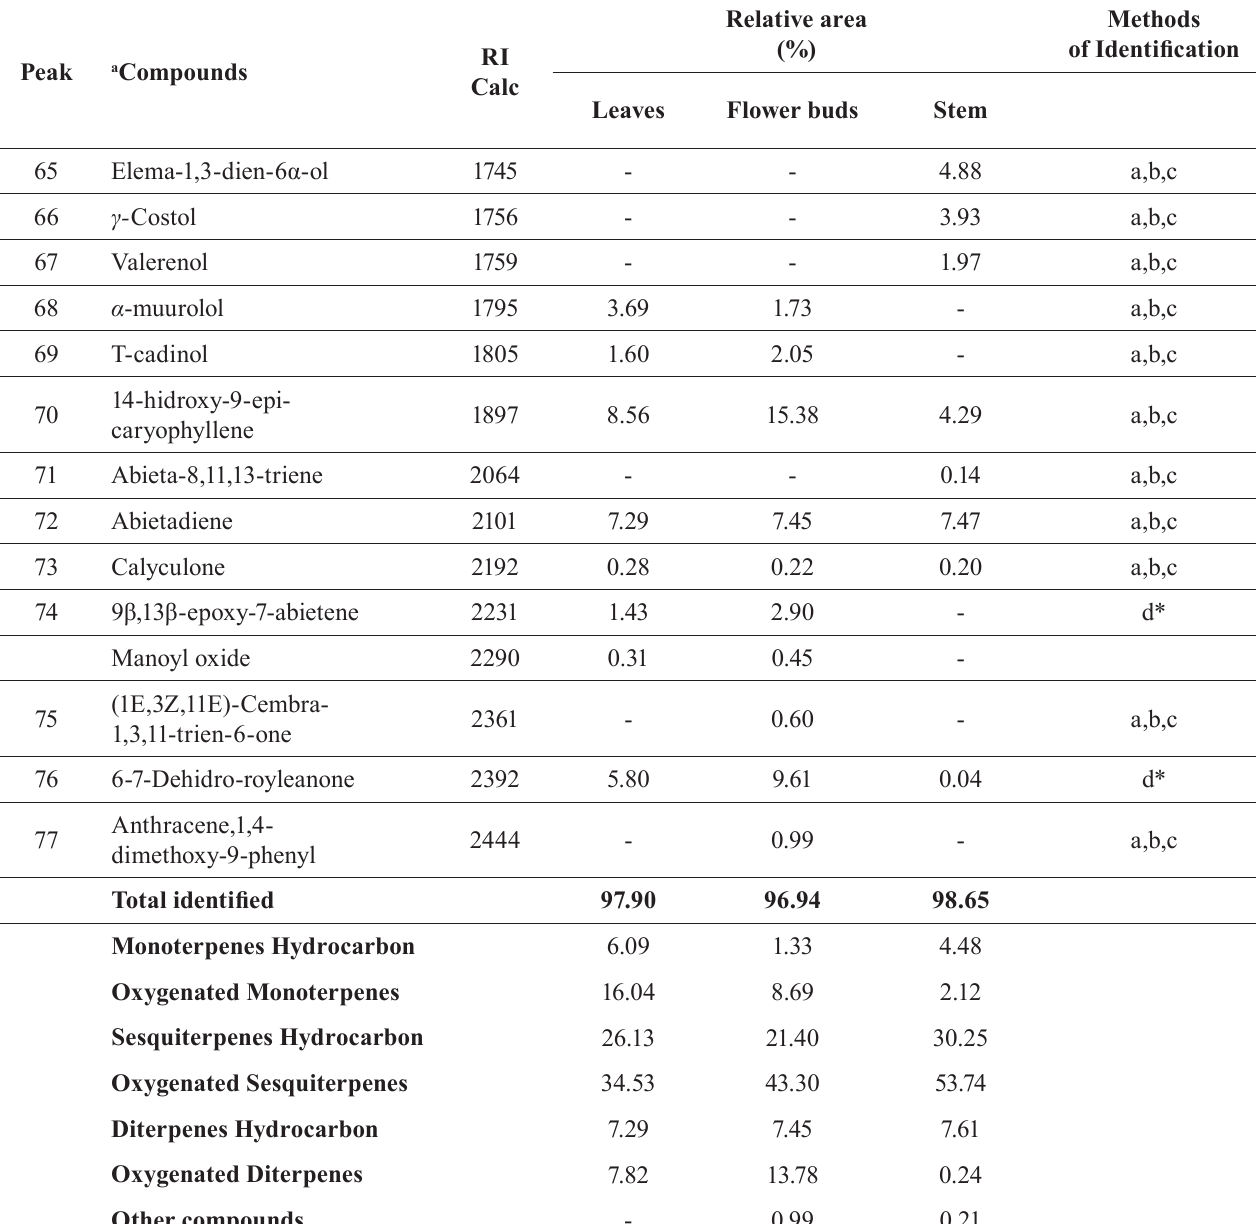
TABLE I - C hemical composition of Tetradenia riparia leaves, flower buds and stem essential oil